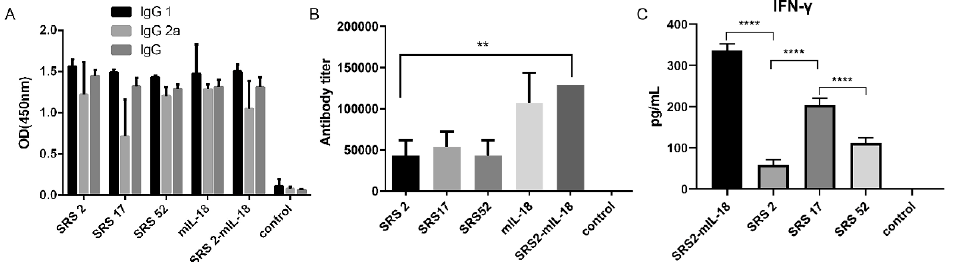
Figure 2. Analysis of the levels of IgG antibodies and IFN- γ in mouse serum. ( A ) Distribution of the IgG subtypes IgG1 and IgG2a in immunized mice. The levels of the IgG subtypes IgG1 and IgG2a in the serum of mice 10 days after the last immunization were analyzed by ELISA. The results are expressed as the mean OD450 ± SD values. Serum was collected one day prior to each immunization and evaluated by ELISA. ( B ) The levels of antibody titer in the mouse serum 10 days after the last immunization were analyzed by ELISA. The results are shown as the mean potency, and signifi- cantly differences are indicated by “ ** ”. ( C ) The levels of IFN- γ in the mouse serum 10 days after the last immunization were analyzed by ELISA. Nonimmunized mice served as negative controls. “ ** ” represents significantly different marked p < 0.01 and “ **** ” represents extremely different marked p < 0.0001. After N. caninum infection, the weight loss of mice in the SRS2 and SRS52 groups was lower than those of the mice in the negative control group, but the difference was not significant; however, weight loss was significantly reduced in the SRS17 group. In addi-